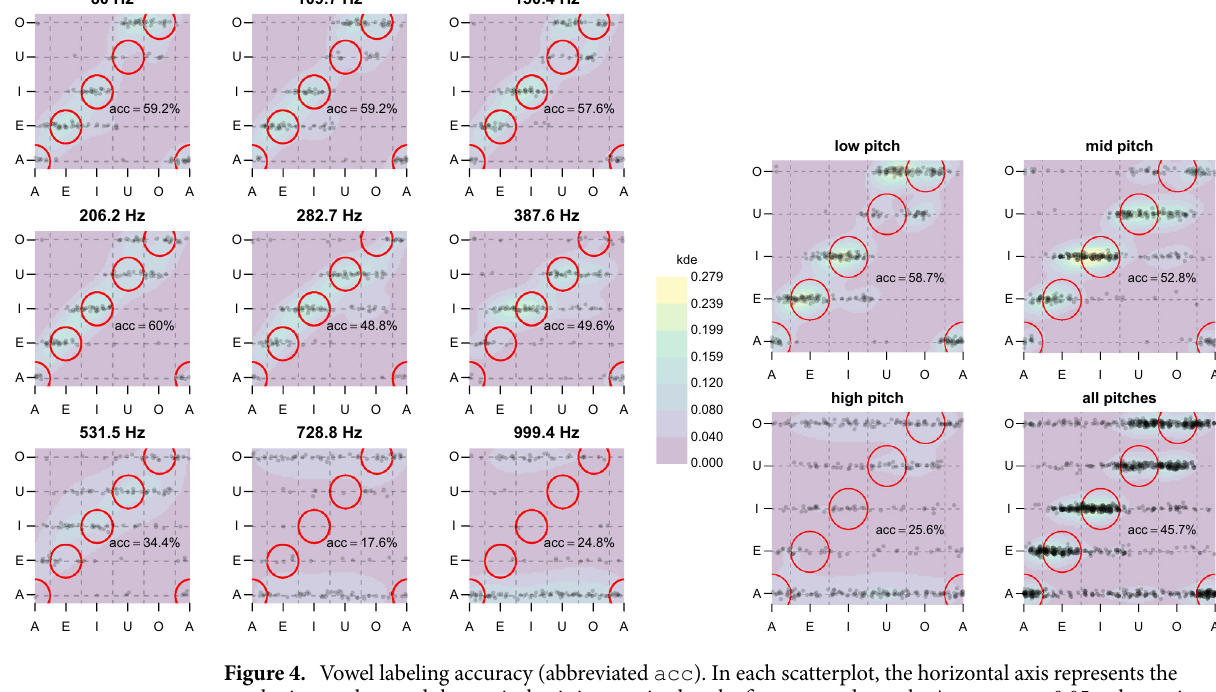
Figure 4. Vowel labeling accuracy (abbreviated acc ). In each scatterplot, the horizontal axis represents the synthetic vowel set and the vertical axis is quantized to the five reported vowels. A zero-mean 0.05-std gaussian jitter has been added, and individual responses have been rendered as tiny black dots with 80% transparency. The background shows a bivariate kernel density estimate. The red circles represent the areas where most points are expected for accurate labeling. (Left) Vowel labeling accuracy at the nine different pitches; (Right) Vowel labeling accuracy in the three pitch ranges and for all pitches.